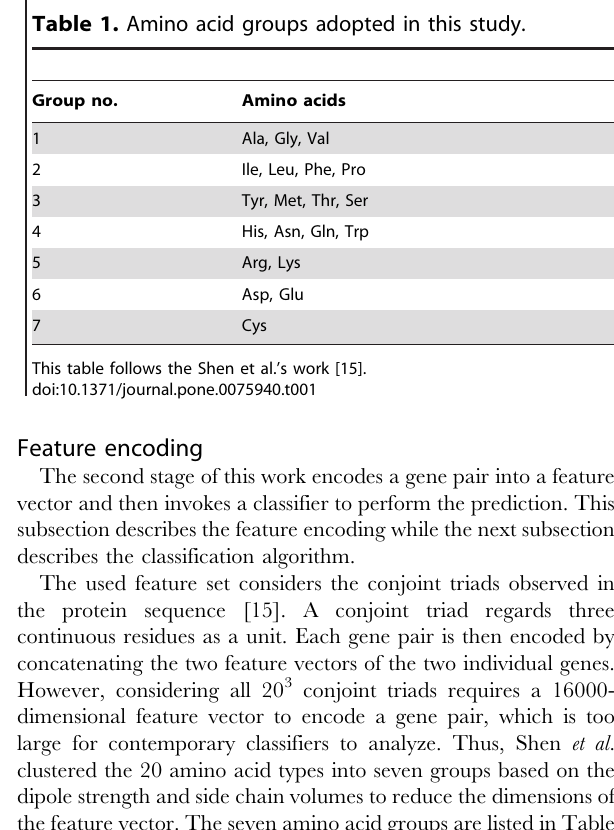
Table 1. Amino acid groups adopted in this study.